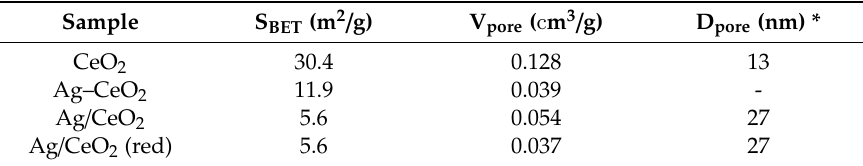
Table 1. Textural characteristics of the Ag catalysts and CeO 2